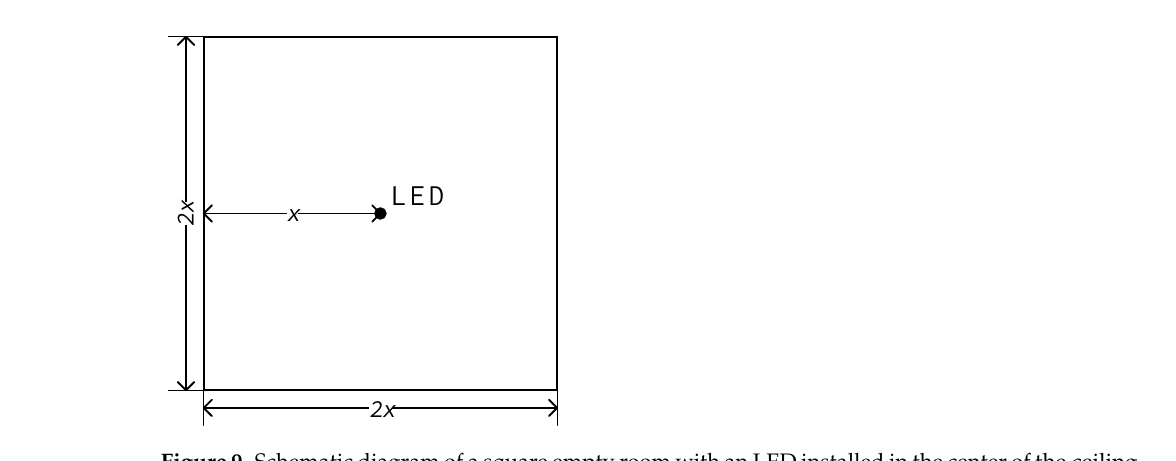
Figure 9. Schematic diagram of a square empty room with an LED installed in the center of the ceiling.